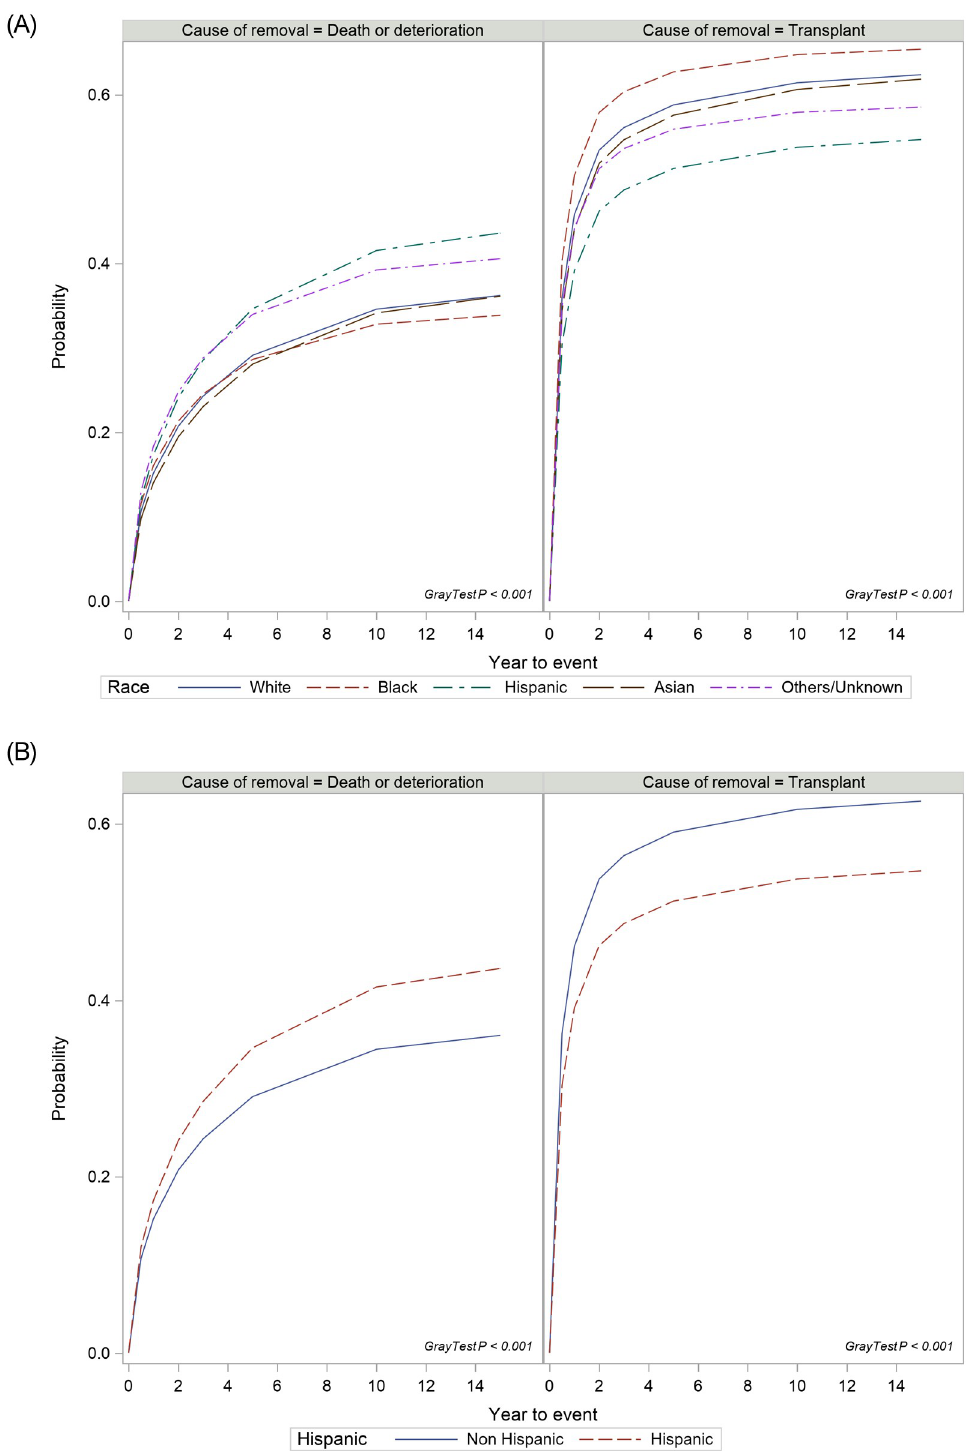
Fig 1. A. Cumulative incidence of removal due to death or deterioration and liver transplantation stratified by race; B. Cumulative incidence of removal due to death or deterioration and liver transplantation in Hispanics when compared to other races